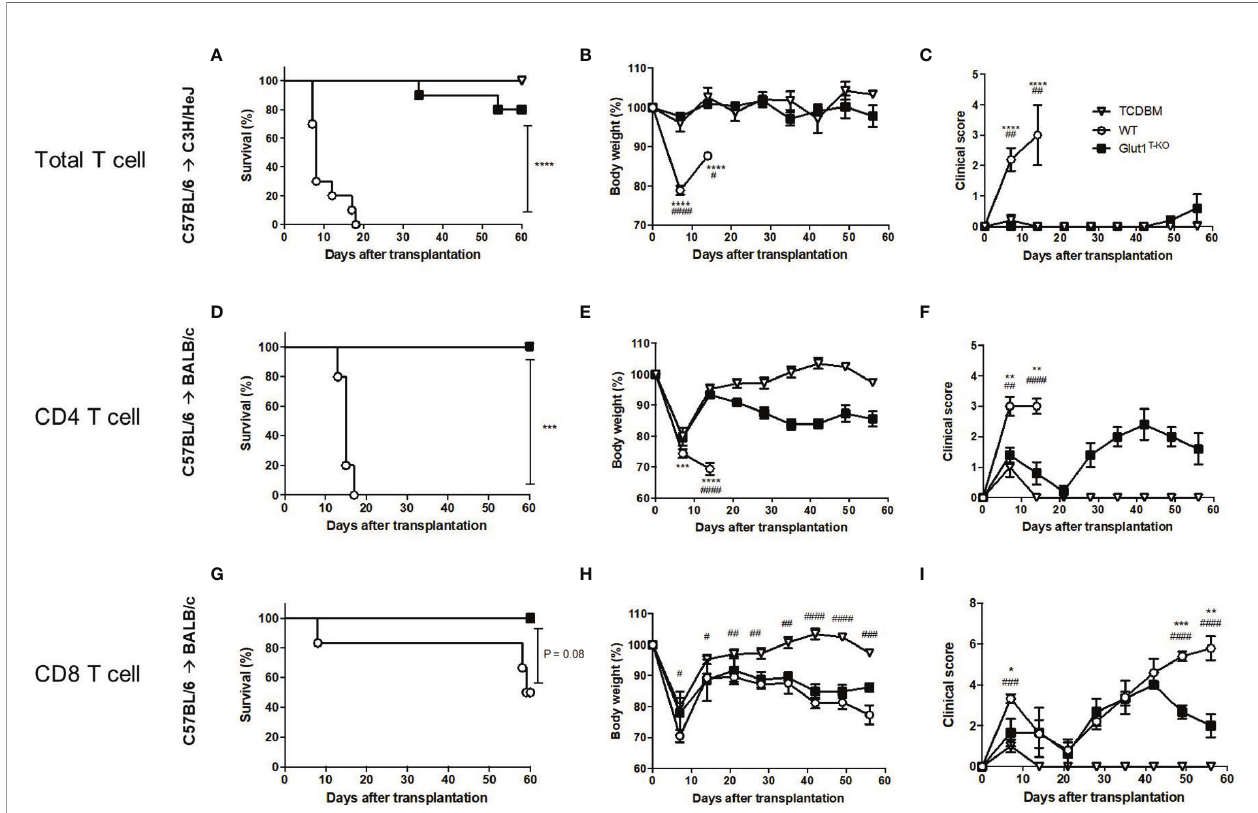
FIGURE 1 | Glut1 is required for donor T cells to induce acute GVHD. Acute GVHD was induced by transplantation of C57BL/6-derived 1 x 10 7 TCDBM or along with 1 x 10 6 WT or Glut1 T-KO total T cells into lethally irradiated (9.5 Gy) C3H/HeJ recipients (A – C) . Lethally irradiated (8.5 Gy) BALB/c recipients were transplanted with 1 x 10 6 WT or Glut1 T-KO CD4 + (D – F) or CD8 + T cells (G – I) , along with 1 x 10 7 TCDBM from C57BL/6 donors. Recipients were monitored for survival (A, D, G) , body weight (B, E, H) , clinical score (C, F, I) up to 56 days after transplantation. Data were representative of three experiments. ****P < 0.0001, ***P < 0.001, log- rank test [n = 10 per group, A; n = 5 per group, ( D, G )]; data are shown as mean ± SEM (B, C, E, F, H, I) , *P < 0.05, **P < 0.01, ***P < 0.001, ****P < 0.0001 (Glut1 T-KO vs. WT); # P < 0.05, ## P < 0.01, ### P < 0.001, #### P < 0.0001(TCDBM vs. WT), 2-tailed Student t